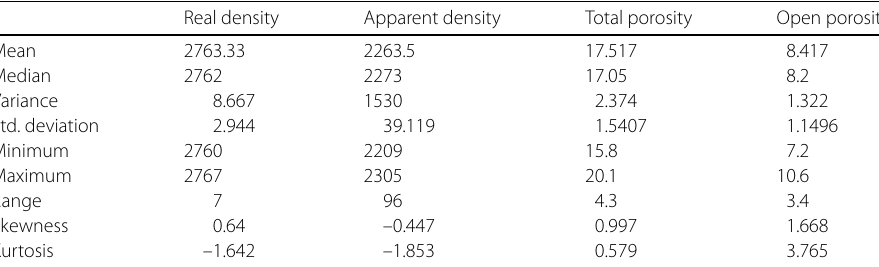
Table 1 The results of the descriptive statistics of the physical data Real density Apparent